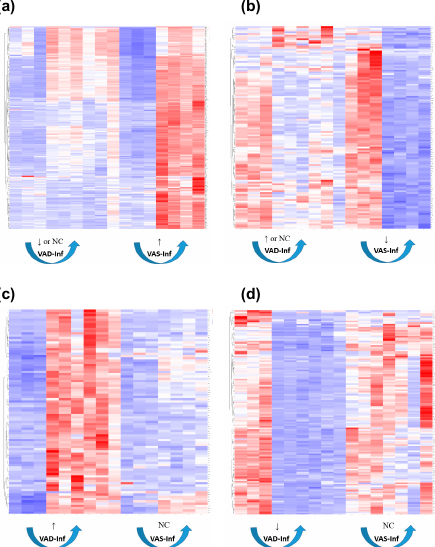
Figure 3. Heatmap for DEGs corresponding to four different scenarios for the interaction effect in the colon. ( a ) Scenario 1. ( b ) Scenario 2. ( c ) Scenario 3. ( d ) Scenario 4. For full lists of the genes corresponding to those scenarios see the supplementary Excel file. Red: higher expression; blue: lower expression. Non-infected VAD: columns 1, 2, and 3. Infected VAD: columns 4, 5, 6, 7, 8, and 9. Non-infected VAS: columns 10, 11, and 12. Infected VAS: 13, 14, 15, and 16. ↑ means upregulation, ↓ means downregulation. Abbreviations : differentially expressed gene (DEG), no change (NC), vitamin A-sufficient (VAS), vitamin A-deficient (VAD), infection effect under the VAS status (VAS-Inf), infection effect under the VAD status (VAD-Inf). Nutrients 2022 , 14 , 1563